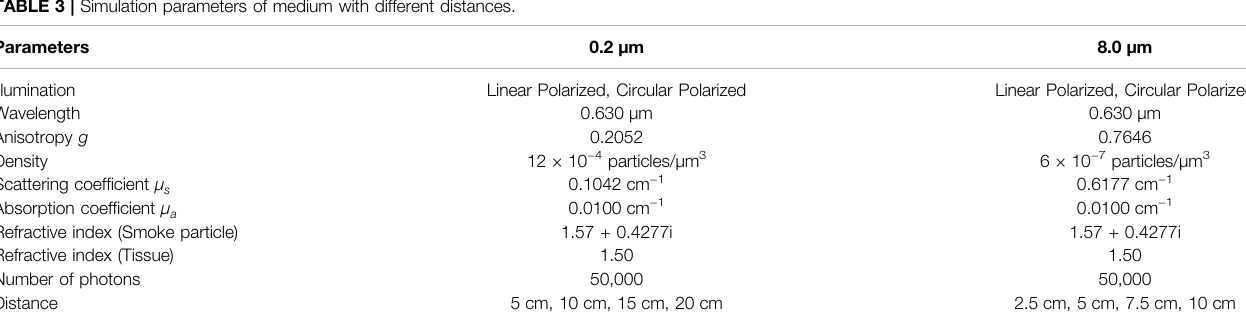
TABLE 3 | Simulation parameters of medium with different